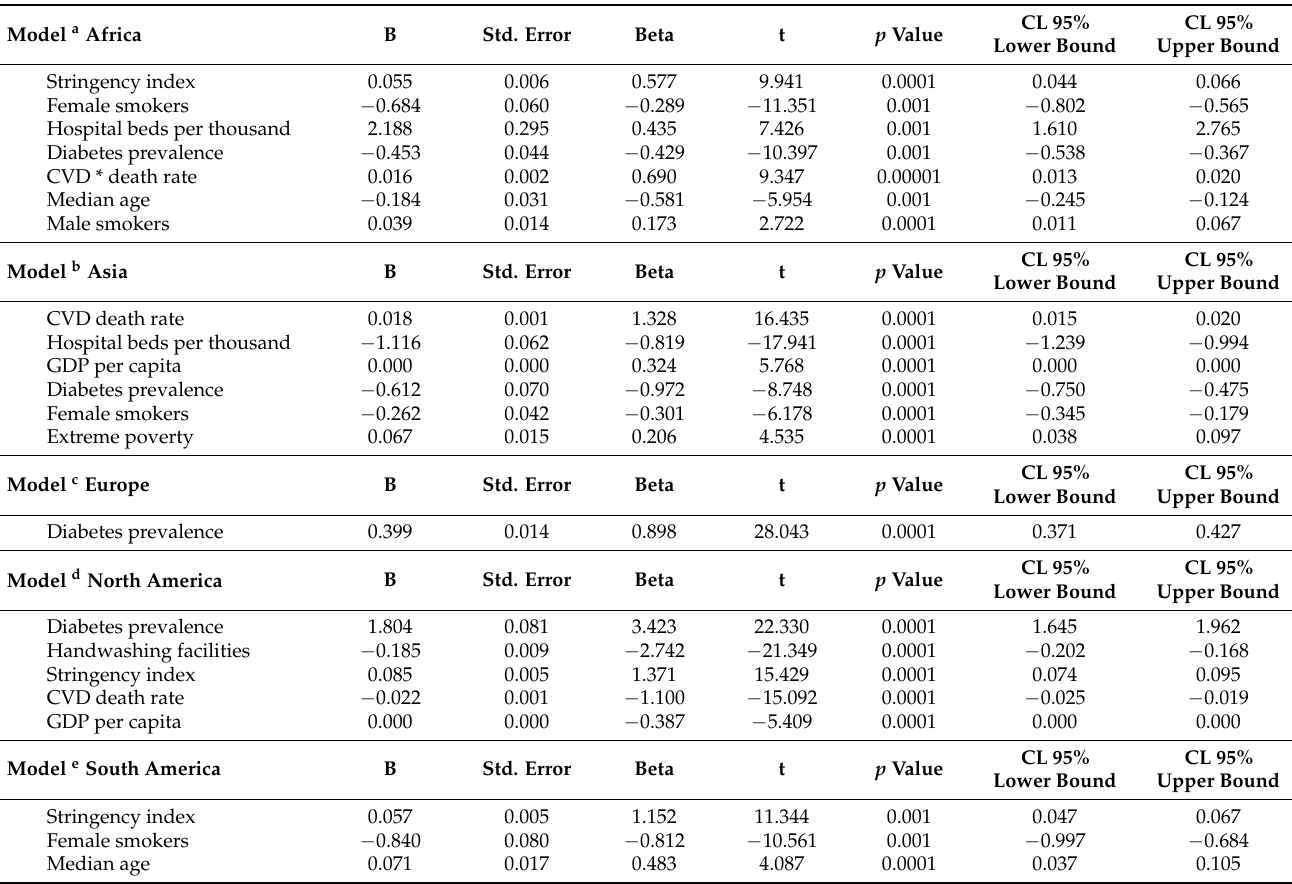
Table 1. Socio-economic risk factors associated to mortality rate.